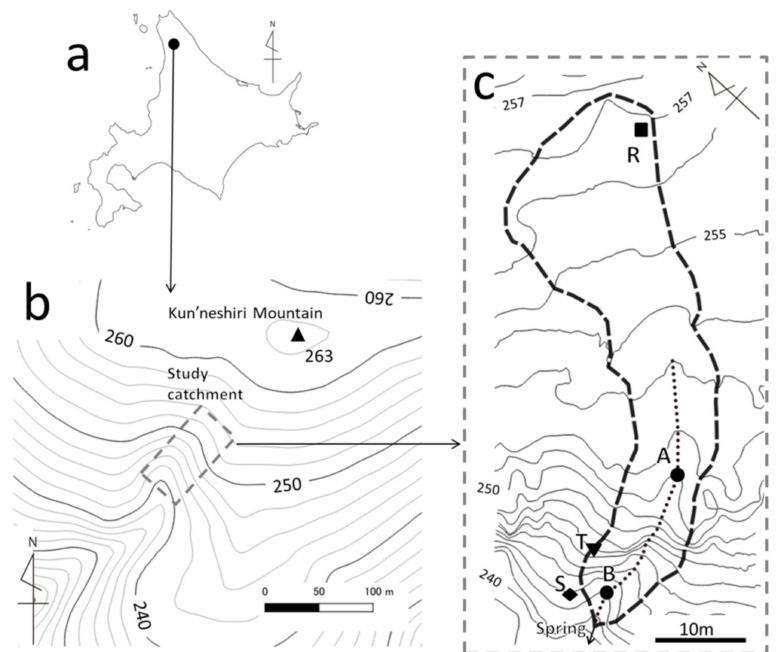
Figure 1. Maps of ( a ) Hokkaido, ( b ) the Kunneshiri Mountain area in Nakagawa Experimental Forest, and ( c ) the study catchment. In panel ( b ), black and gray contours represent intervals of 10 and 2 m, respectively. In panel ( c ), the contour interval is 1 m. Dotted and dashed lines in panel ( c ) indicate an unchanneled hollow in the study catchment and the catchment boundary,